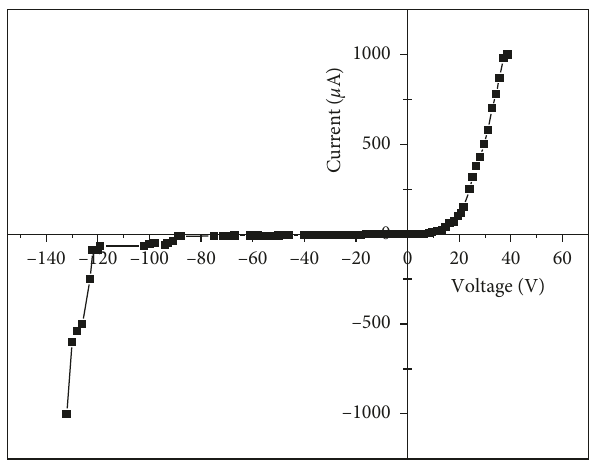
Figure 4: Current-voltage characteristics of p - i - n junction in 4 H -SiC